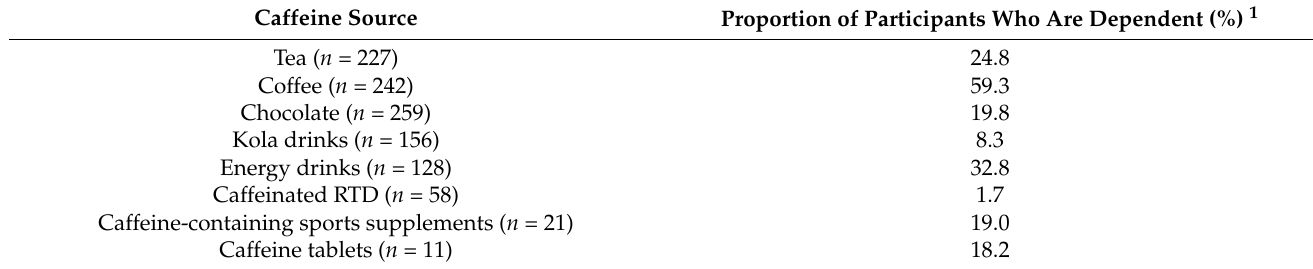
Table 3. Proportion of participants who reported dependence on caffeine